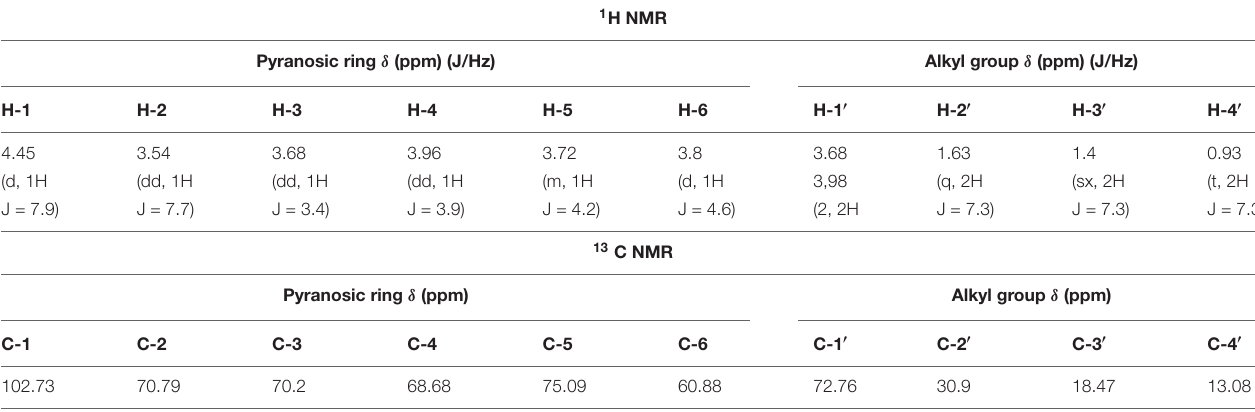
TABLE 3 | 1 H and 13 C Nuclear magnetic resonance for butyl- β -galactoside.